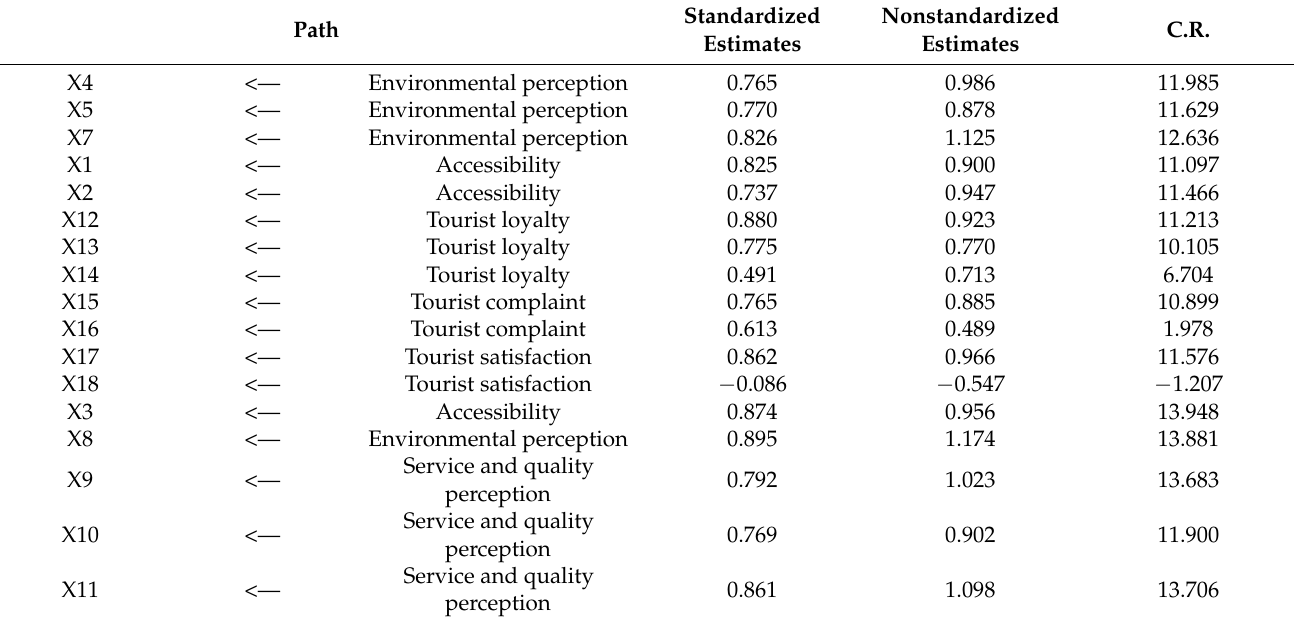
Table 9. Path coefficients between latent variables and observed